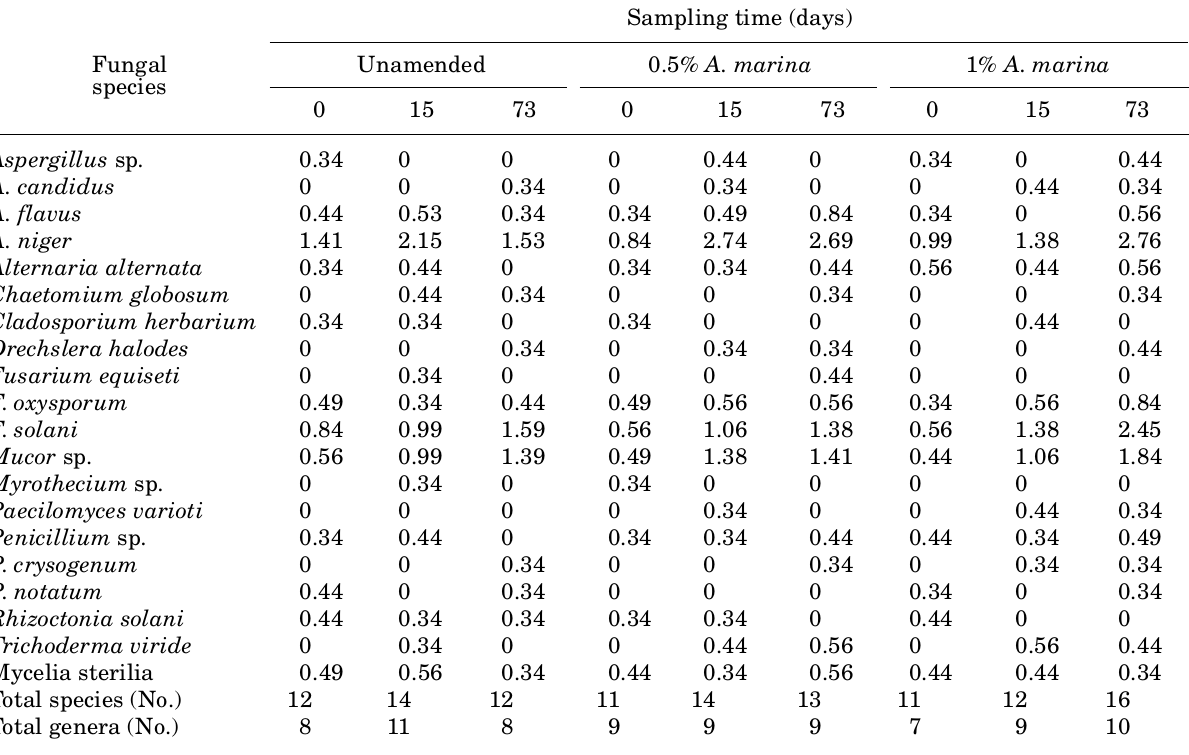
Table 2. Effect of soil amended with powdered leaves of Avicennia marina at concentrations of 0, 0.5 and 1% on soil (x+1) and recorded at 0 (start of the experiment), 15 (6 days before fungal community structure expressed as log 10 seed sowing) and 73 (time of harvest)